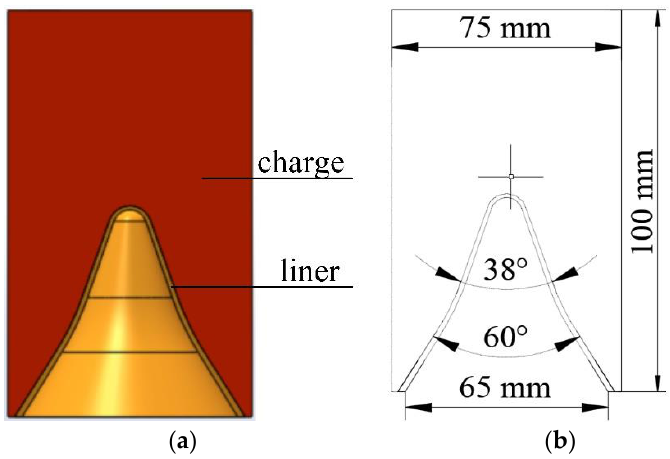
Figure 1. Structure diagram of the SCJ warhead: ( a ) 3D drawing of warhead, and ( b ) structural dimension drawing of warhead.